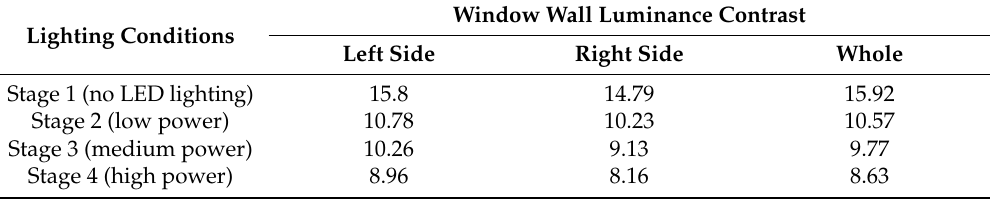
Table 2. Average median luminance contrast of the left and right-hand side on the window wall, as well as the luminance contrast of the whole window wall areas during each lighting condition.